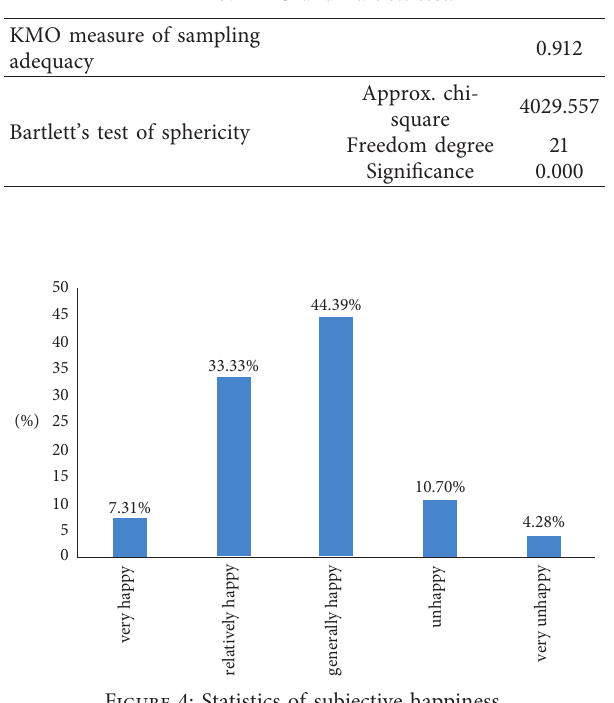
Figure 4: Statistics of subjective